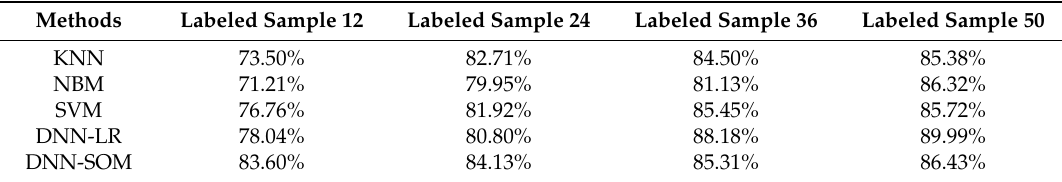
Table 3. Accuracy of different algorithms varies with the sample of the labeled